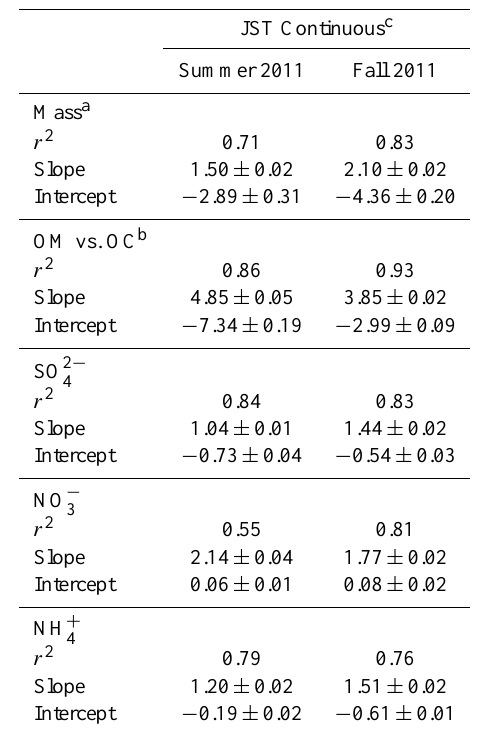
Table 4. Correlations between the ACSM and the collocated mea- surements at JST site. Slope and intercept ± 1 standard deviation from each linear regression correlations are